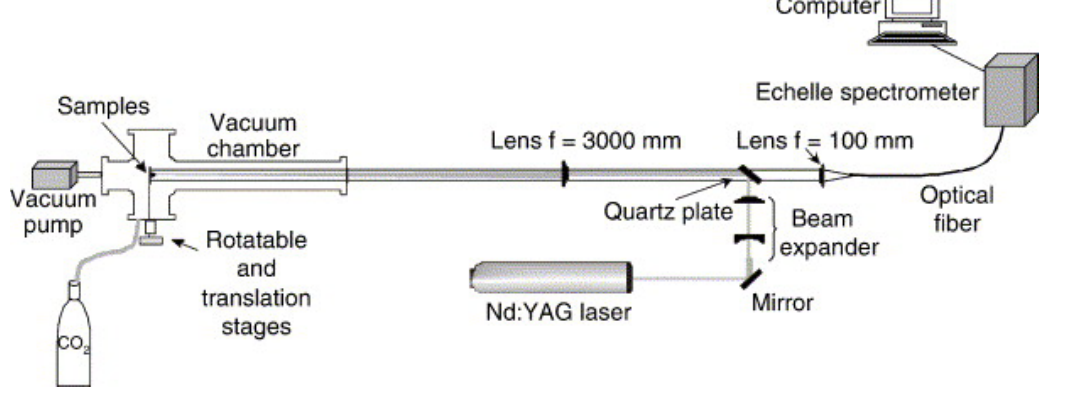
Figure 1. Schematic of typical apparatus for a pressure and gas composition LIBS studies. Reprinted from reference